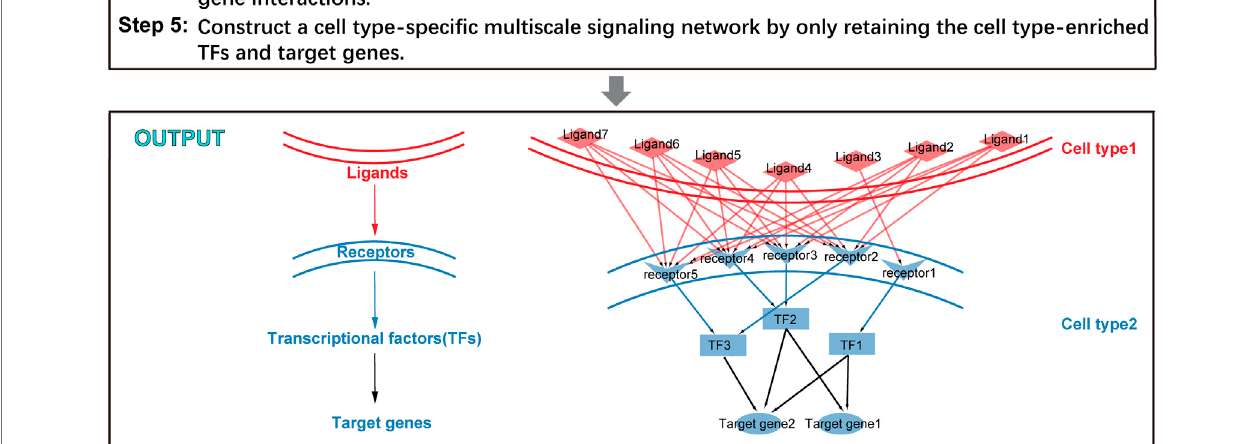
Frontiers in Genetics |